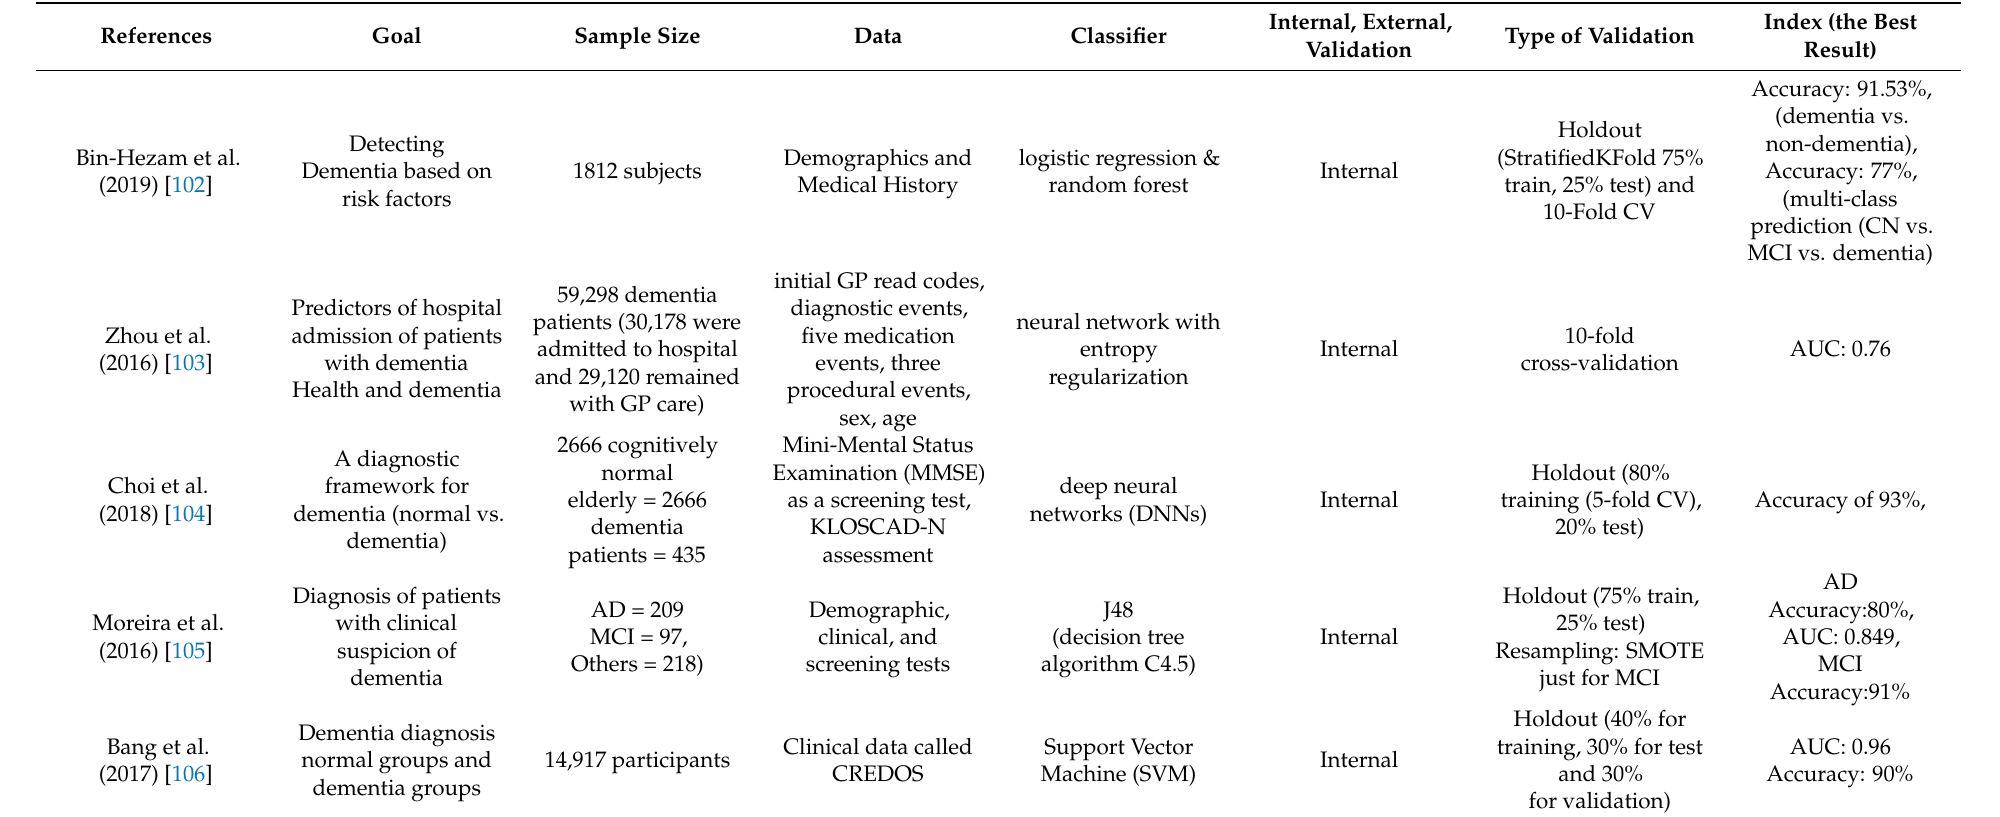
Table 7. CAD methods for mental and neurological disorders